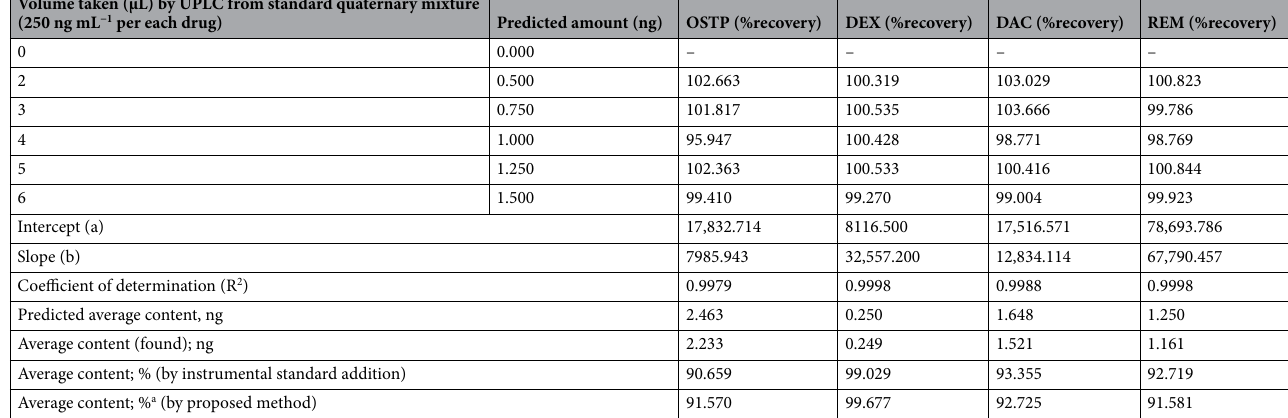
Table 3. Innovative instrumental standard addition. a It is the same sample used in the innovative instrumental standard addition method.